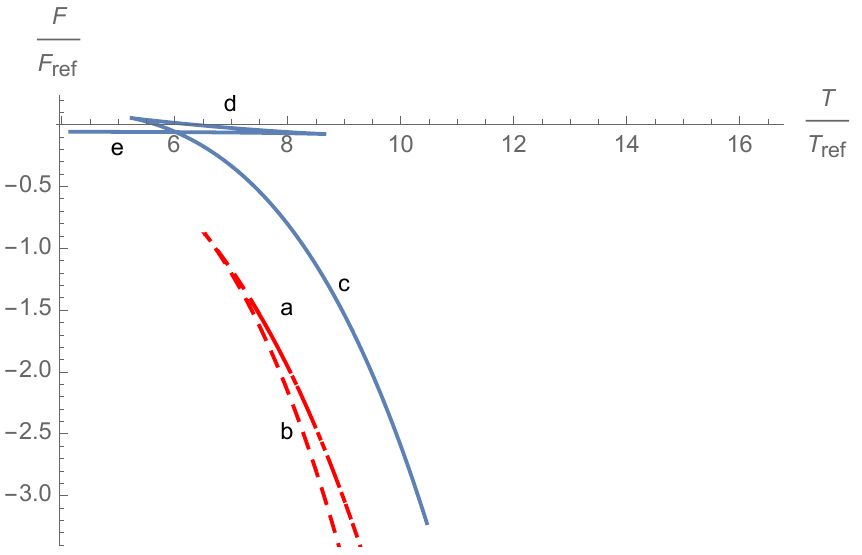
Figure 26 . Comparison of the free energies of the solutions that belong to region I (blue, solid) and II (red, dashed).